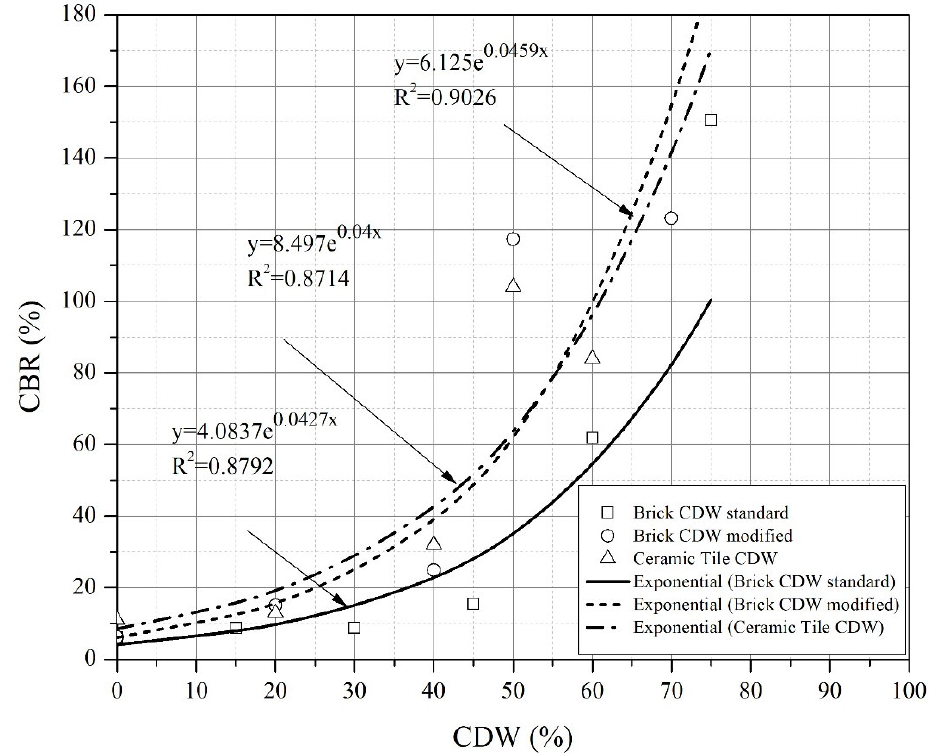
Figure 10. CDW content CBR correlation.